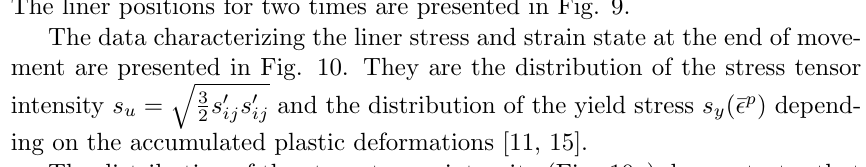
The liner positions for two times are presented in Fig.